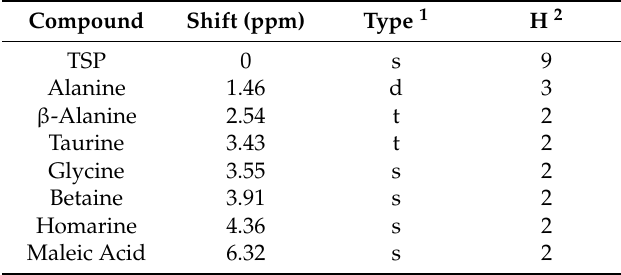
Table 4. Chemical shifts key osmolytes used for relative quantification.